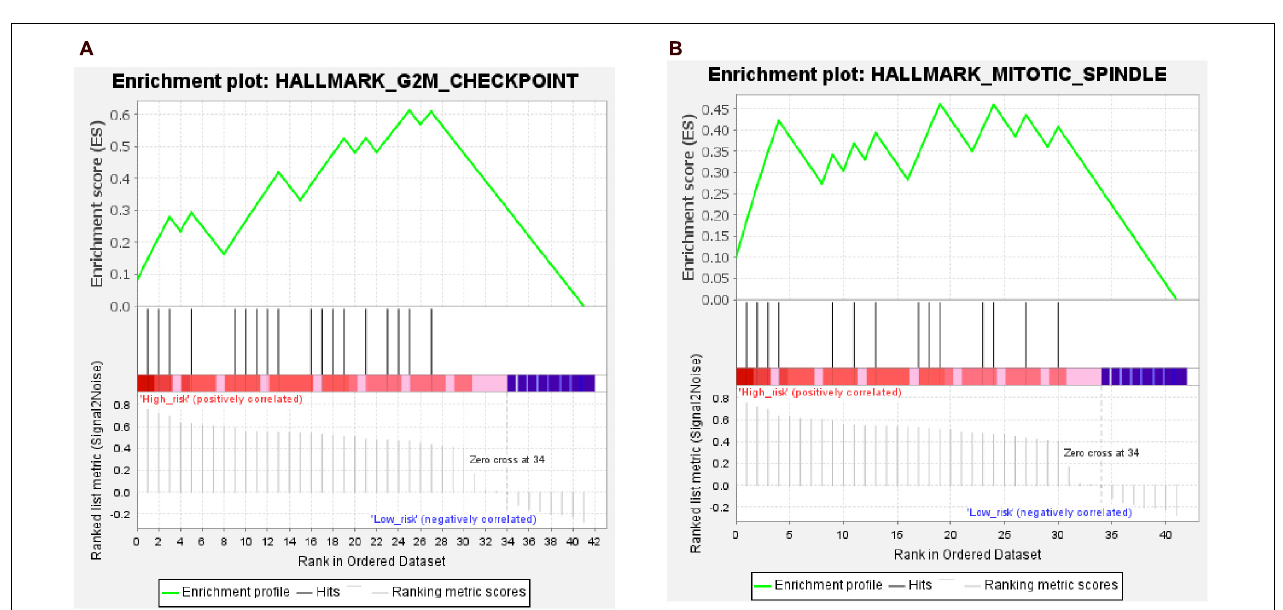
FIGURE 11 | Results from gene set enrichment analysis (GSEA) of hub genes in the high-risk group. (A) Hallmark G2M checkpoint pathway. (B) Hallmark mitotic spindle pathway.